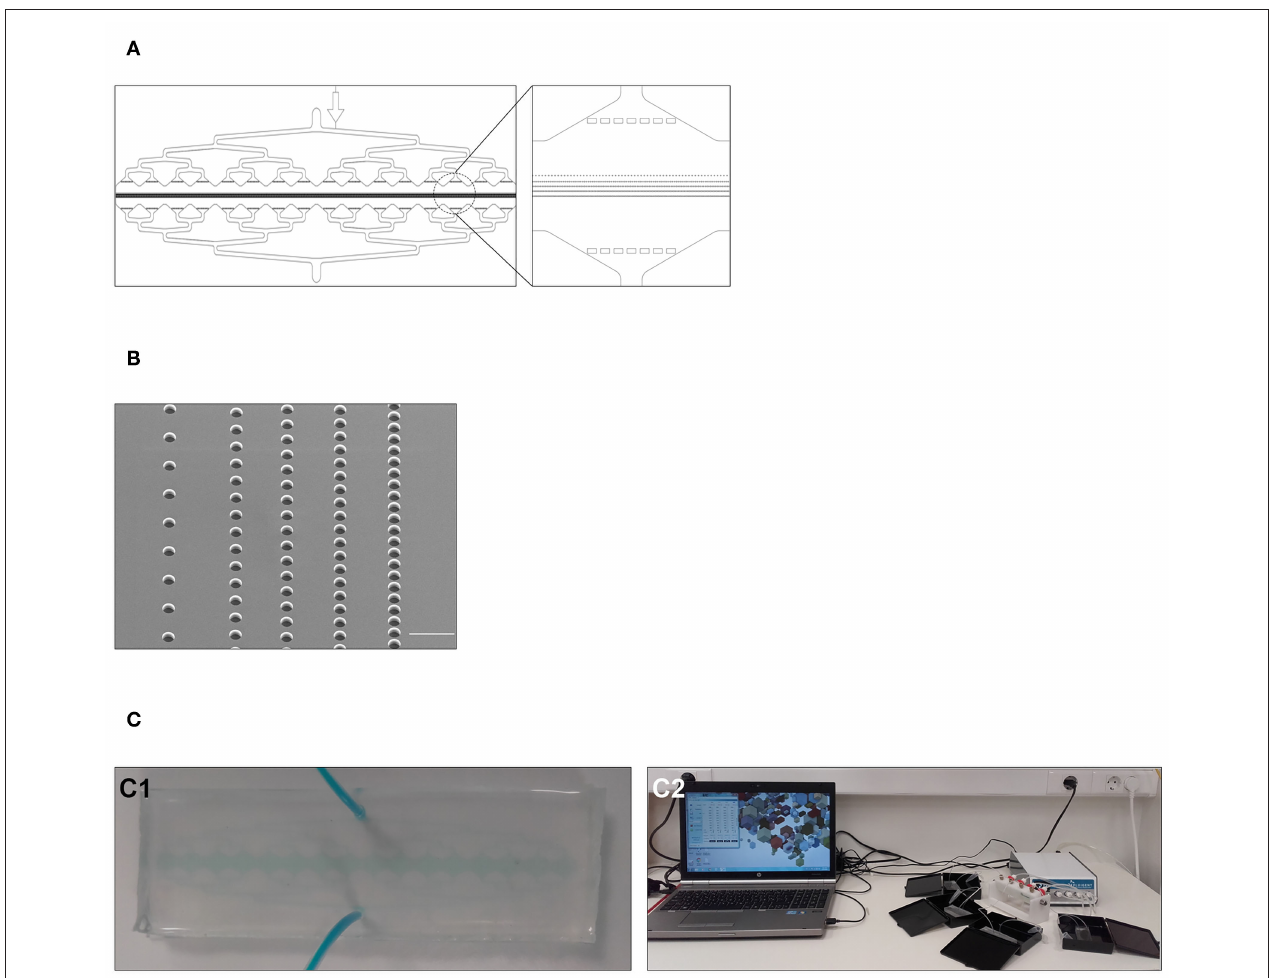
FIGURE 2 | Design and fabrication of the UriChip. (A) AutoCAD design of the UriChip. Design includes a circular inlet and outlet, square posts for structural support of the channels, pre-filtering system to prevent debris and large cell clusters, and five row of posts with increasingly narrower gap widths (50, 20, 15, 10, and 5 µ m) to separate cells according to their size and deformability. (B) Scanning electron microscopy (SEM) image of the five rows of gaps in the master that will give rise to the posts of the UriChip. Scale bar, 100 µ m. (C1) UriChip after fabrication with PDMS. (C2) Experimental setup for simultaneous analysis of four independent